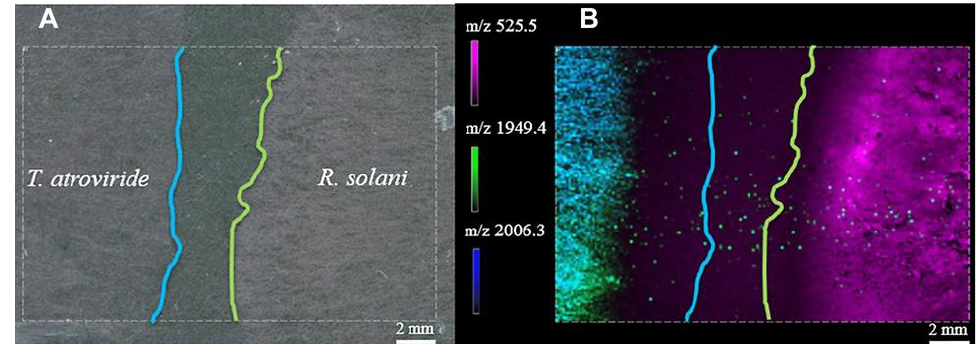
Figure 2. Light microscopic ( A ) and MALDI MSI ( B ) analysis of physically non-interacting Trichoderma atroviride and Rhizoctonia solani hyphae. Figure was reproduced with permission from Holzlechner and colleagues [74]. Table 1. Specific microbial literature operating with MALDI mass spectrometry imaging. TOF: Time-of-Flight, LTQ: Linear Ion Trap, FT-ICR: Fourier-transform ion cyclotron resonance, Q: Quad- rupole, NA: Not applicable.